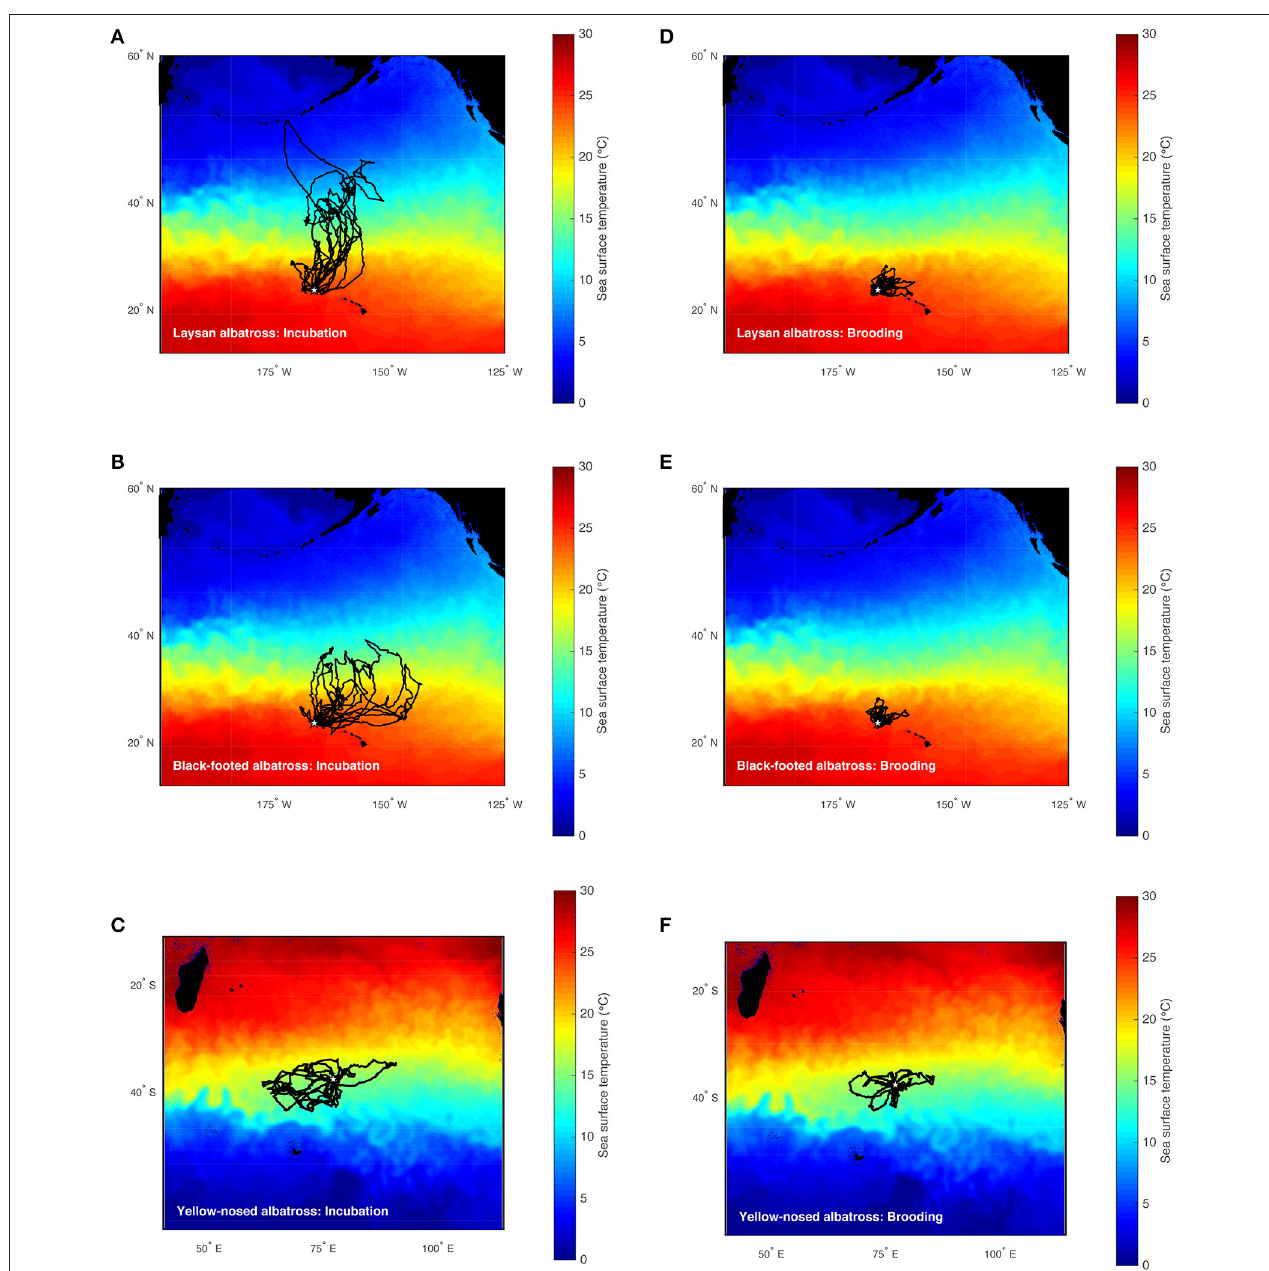
FIGURE 1 | Foraging trips of Laysan, black-footed, and Indian yellow-nosed albatrosses during late incubation (A–C) and brooding (D–F) . Laysan and black-footed albatrosses were tracked at Tern Island, Northwest Hawaiian Islands during 2002–2003, 2004–2005, and 2005–2006, and yellow-nosed albatrosses were tracked at Amsterdam Island, southern Indian Ocean, during 2006–2007 (study colonies indicated with a star). Tracks are superimposed on time-averaged Blended 5-day sea surface temperature ( ◦ C) for the respective study periods retrieved via the NOAA OceanWatch Live Access Server